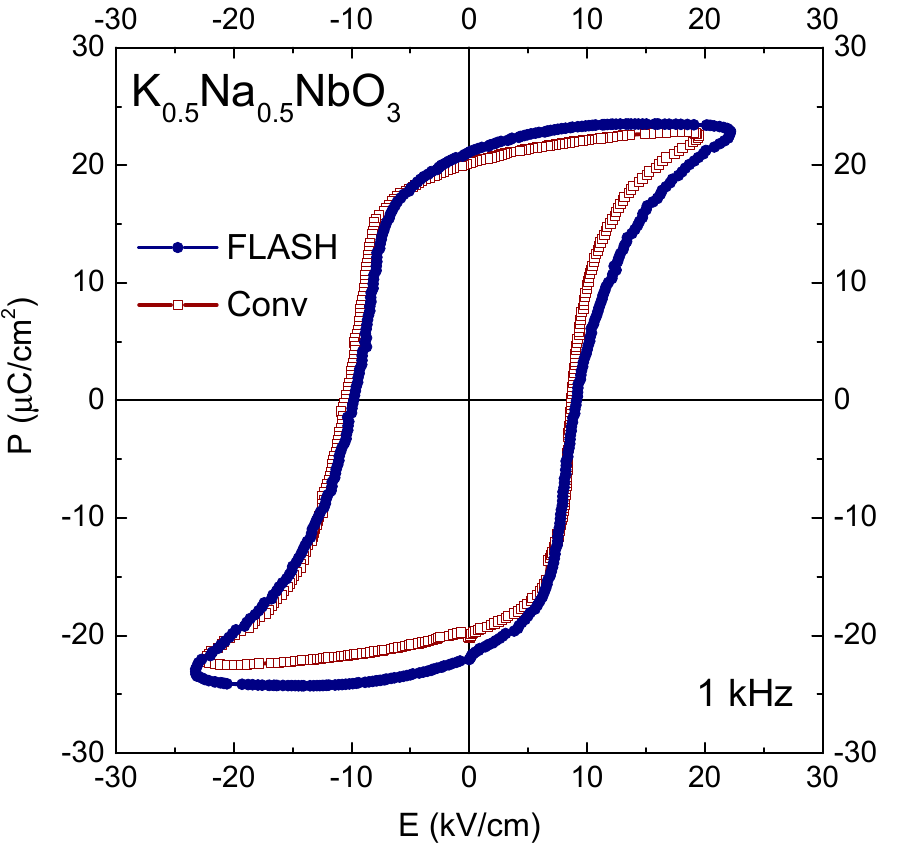
Figure 4. Polarization (P) as a function of applied electric field (E) of conventionally (open squares) and Flash (solid circles) sintered KNN ceramics, measured at 1 kHz and room temperature.